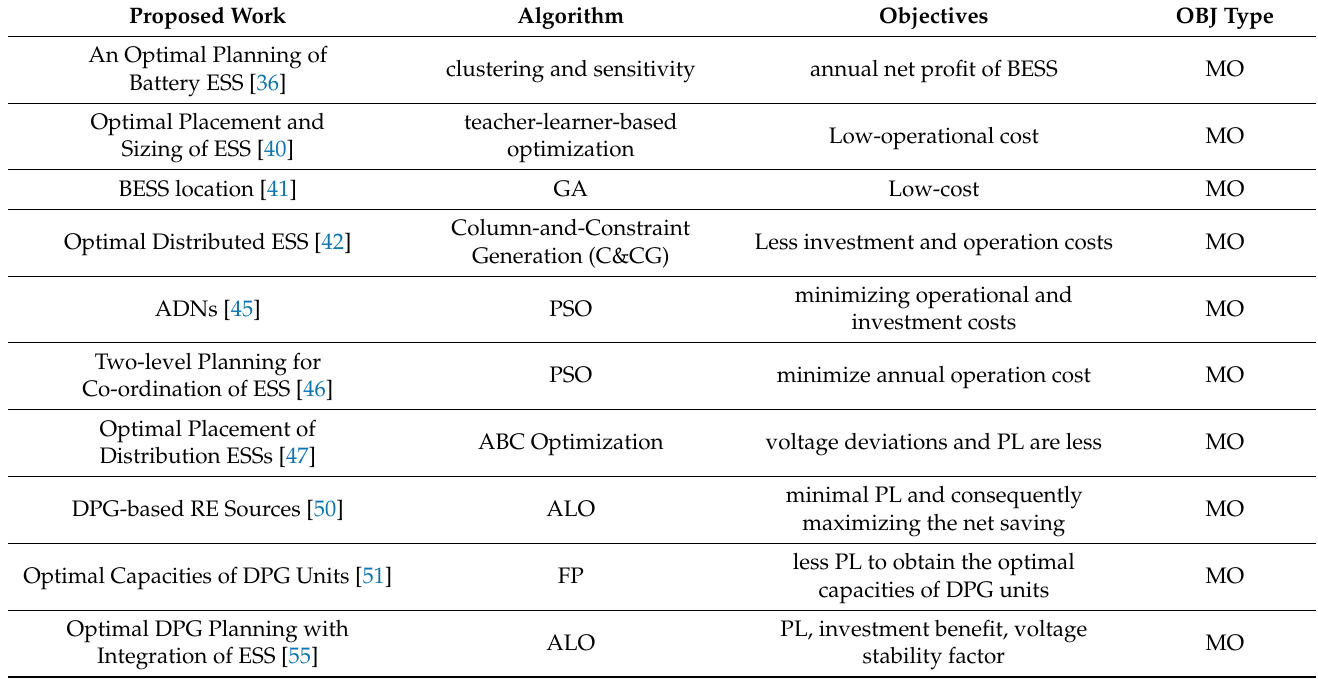
Table 2. Objective analysis of this